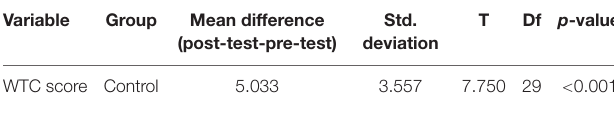
TABLE 8 | Results of paired- sample t-test in comparison of mean score of learners in pre-test and post-test of the experimental